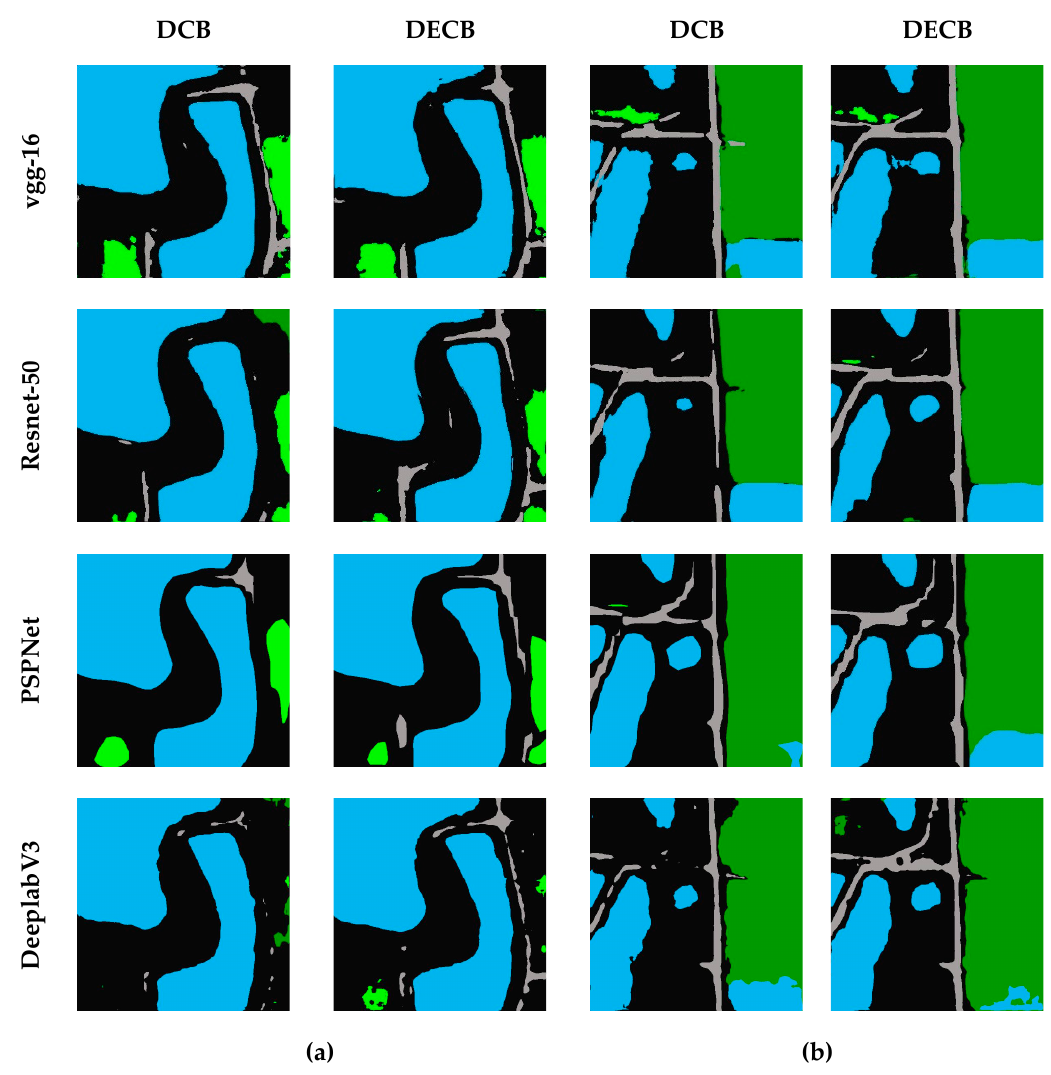
Figure 11. Example of segmentation results for multiple network structures in the LoveDA-r-road dataset: ( a ) example 1 and ( b ) example 2. Table 8. Results of the evaluation of the forest fire burning area dataset